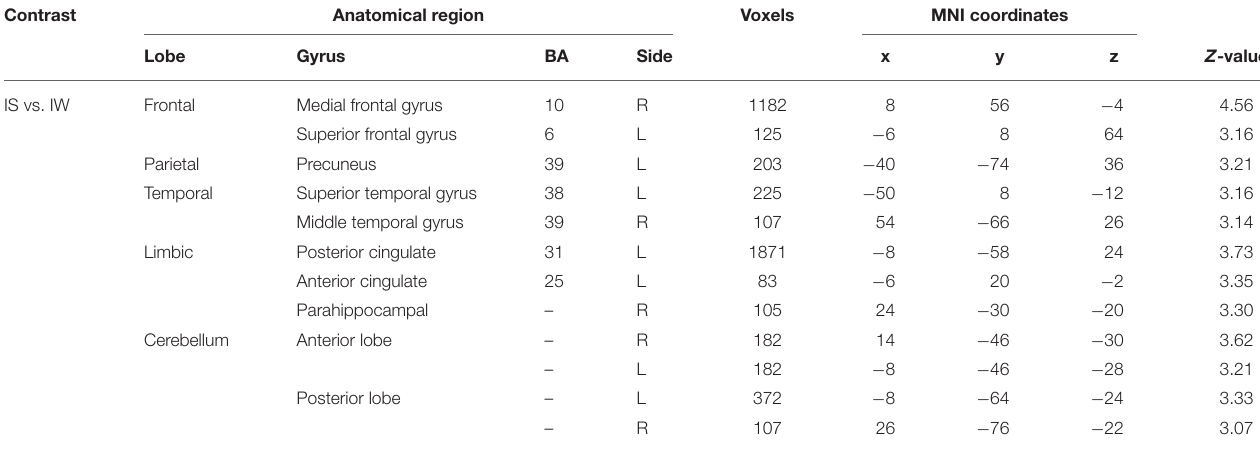
TABLE 3 | Differences in brain activation between post perturbation training imagined slipping and post perturbation training imagined walking conditions. Contrast Anatomical region Voxels MNI coordinates Lobe Gyrus BA Side x y z Z -value IS vs. IW